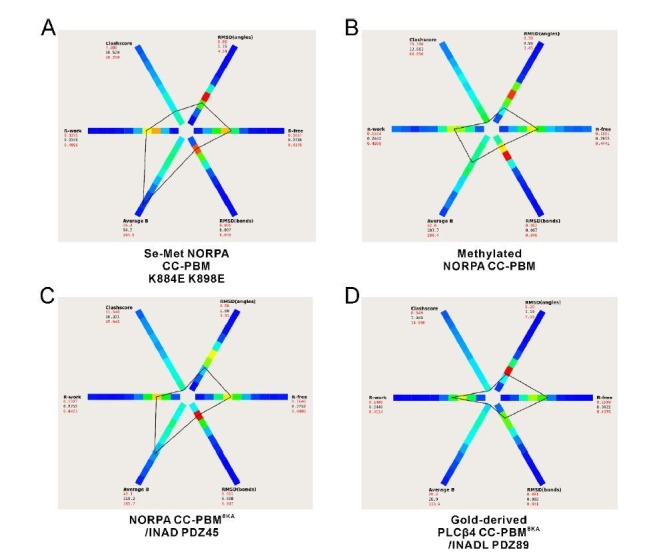
The statistics of our four structures compared to other structures at similar resolutions generated by the program POLYGON in the PHENIX software suite (Urzhumtseva et al., 2009).